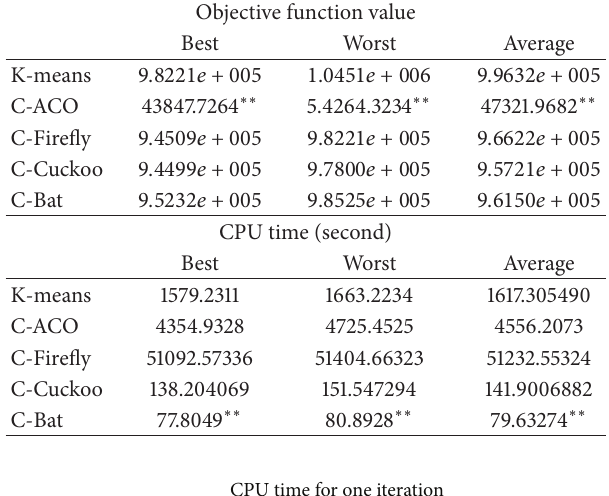
Table 9: Testing objective function fitness and CPU time consump- tion on Libras.